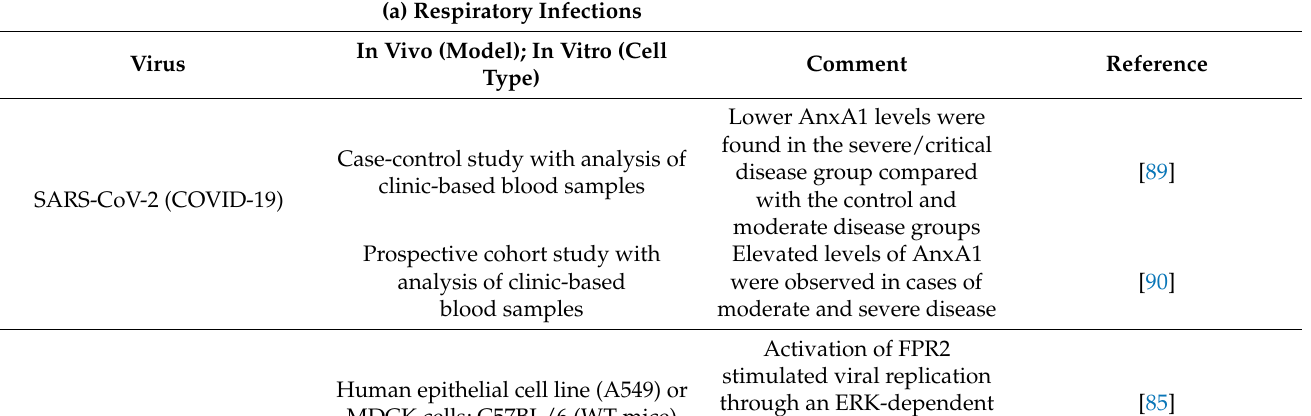
Table 1. Clinical studies and experimental animal models evaluating the role of AnxA1/FPR2 in viral